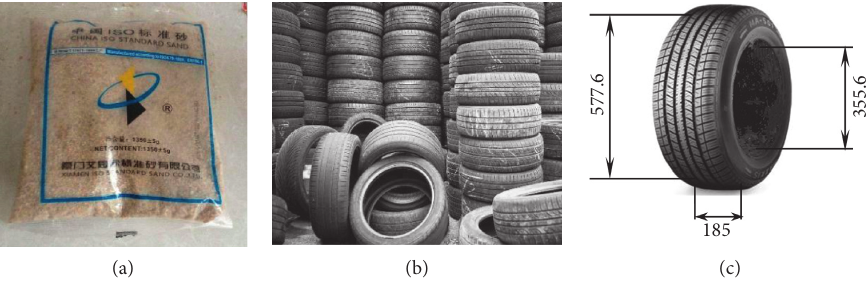
Figure 2: Test materials. (a) Standard sand. (b) Scrap rubber tires. (c) Tire Table 1: Design parameters of specimens.